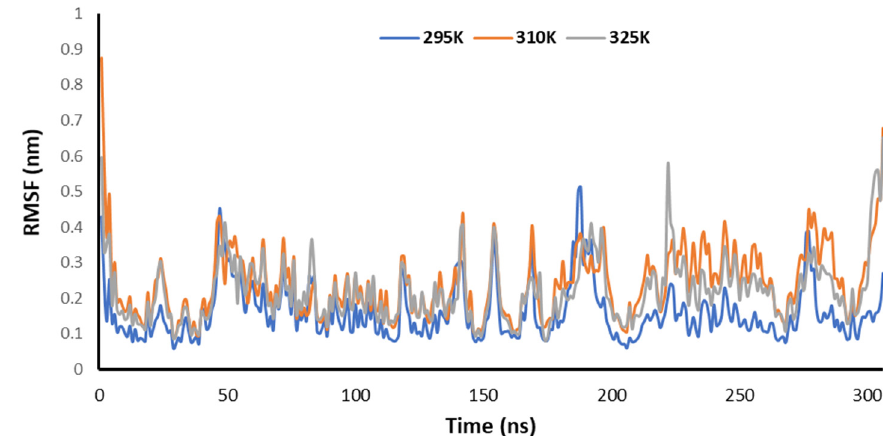
Figure 10. Trajectory of RMSF for the main protease of SARS-CoV-2 with 2DG at 295, 310 and 315 K.